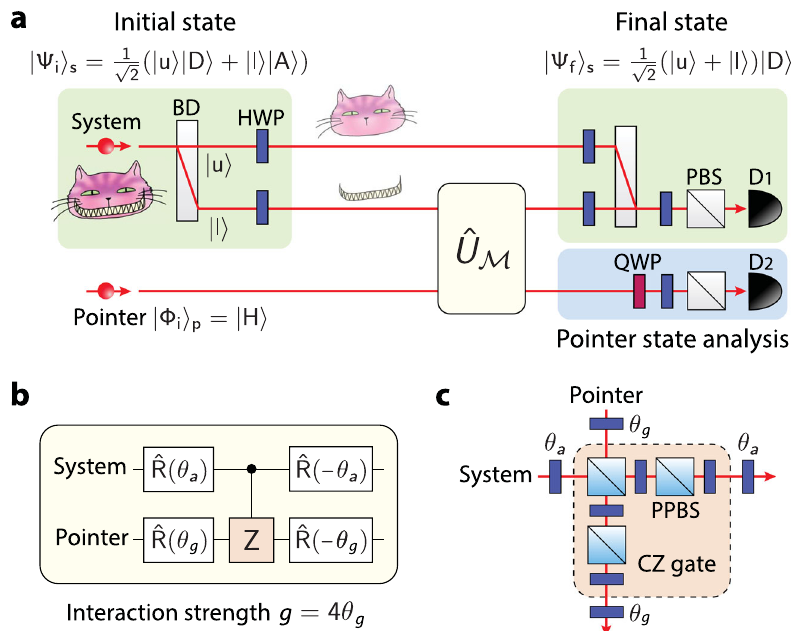
Fig. 2 Experimental schematic. a The system photon and its polarization are disembodied during the transit through the optical paths. The initial and fi nal states are prepared as presented in the fi gure using half-wave plates (HWP), beam displacers (BD), and a polarizing beam splitter (PBS). To probe the presence of the photon and the disembodied polarization state at the lower path, the system photon is weakly coupled to the pointer photon via the unitary interaction ^ U M . The quantum circuit for the unitary interaction is shown in b and its quantum optical implementation is shown in c . Note that the controlled-Z (CZ) gate is implemented via two-photon quantum interference at a partial polarizing beam splitter (PPBS) having polarization-dependent transmissions ( T H = 1, T V = 1/3) with HWP set at 45°. The pointer state is fi nally measured with a quarter-wave plate (QWP), an HWP, and a PBS.